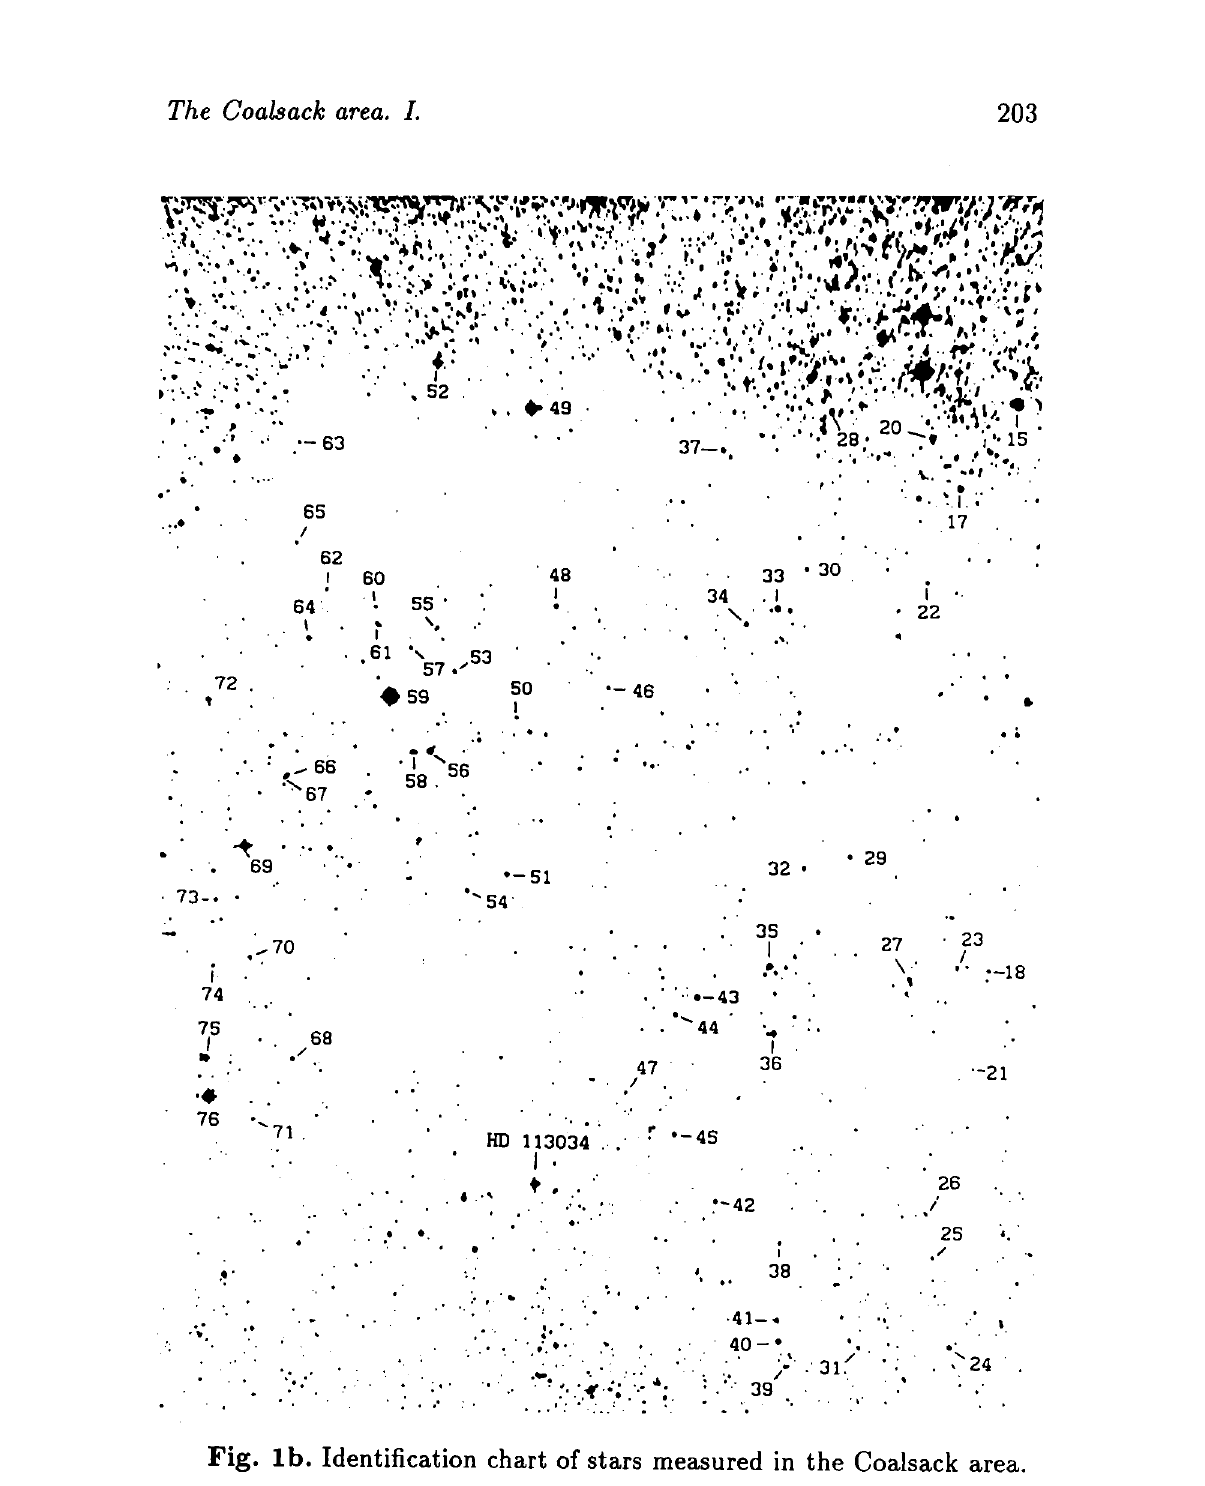
Fig. lb. Identification chart of stars measured in the Coalsack